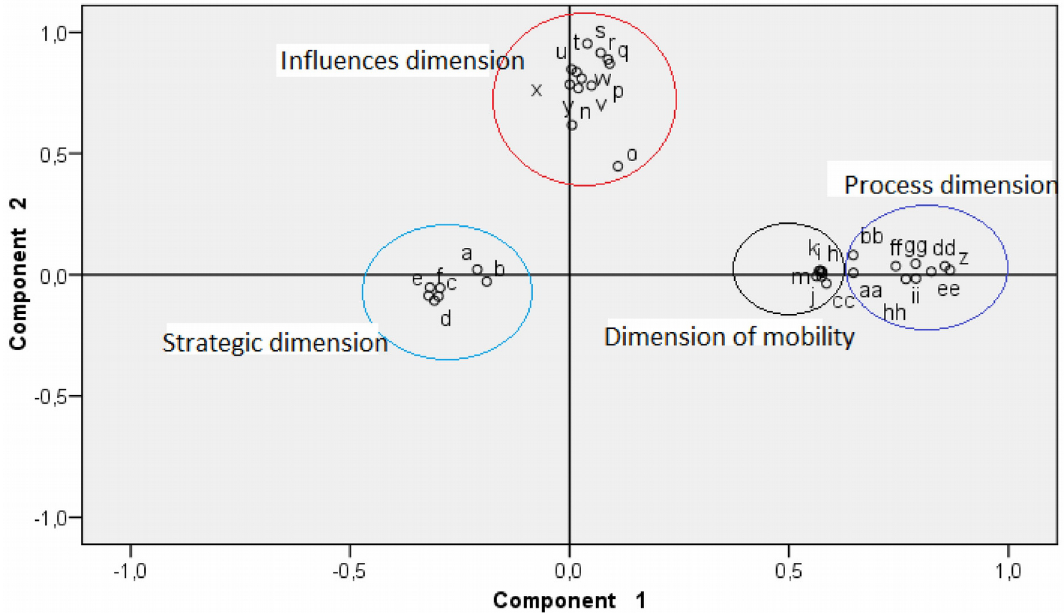
Figure 1. Factorial plane determined by the axes I and II of the principal component